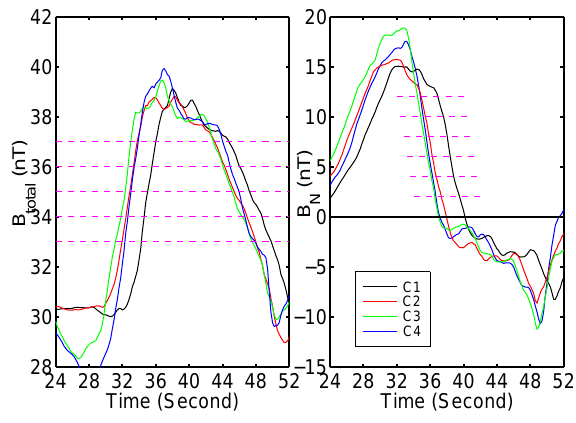
Fig. 3. A flux rope structure observed by FGM/Cluster on 26 Jan- uary 2001, 11:10:24 UT to 11:10:52 UT. (Left panel) Magnetic strength, (right panel) B N components, as a function of time (both 4-s sliding averages at 0.2-s